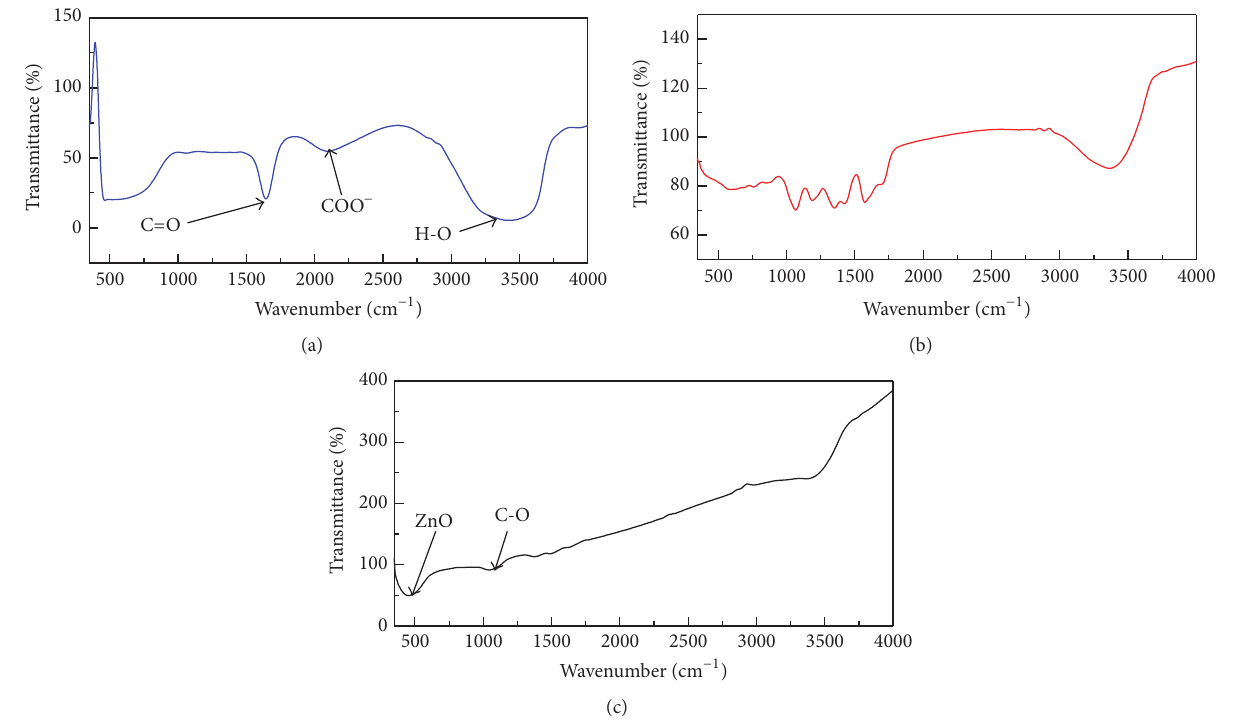
Figure 4: FTIR spectra of (a) pomegranate broth, (b) ZnO before annealing, and (c) ZnO after annealing.